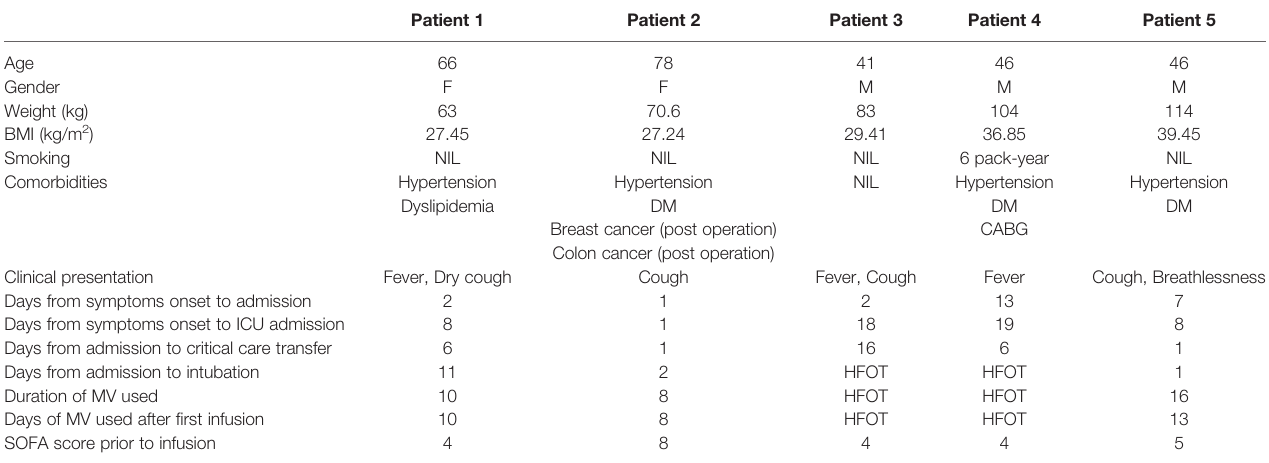
TABLE 1 | Demographics and baseline clinical conditions of the treated